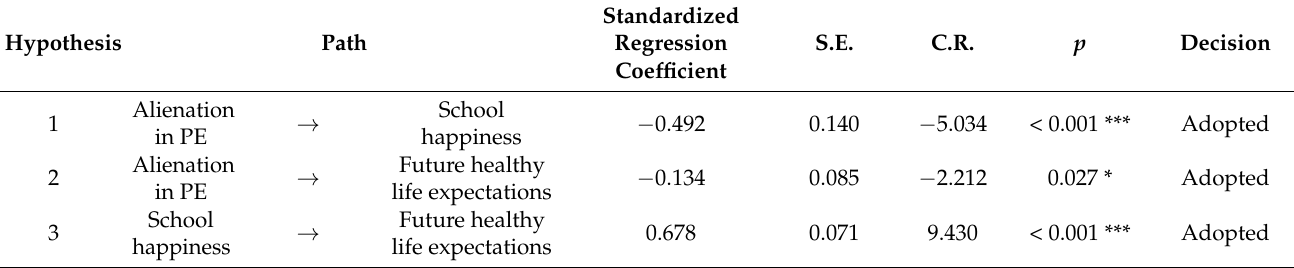
Table 4. Structural relationships among the study parameters during the COVID-19 pandemic. Standardized Hypothesis Path